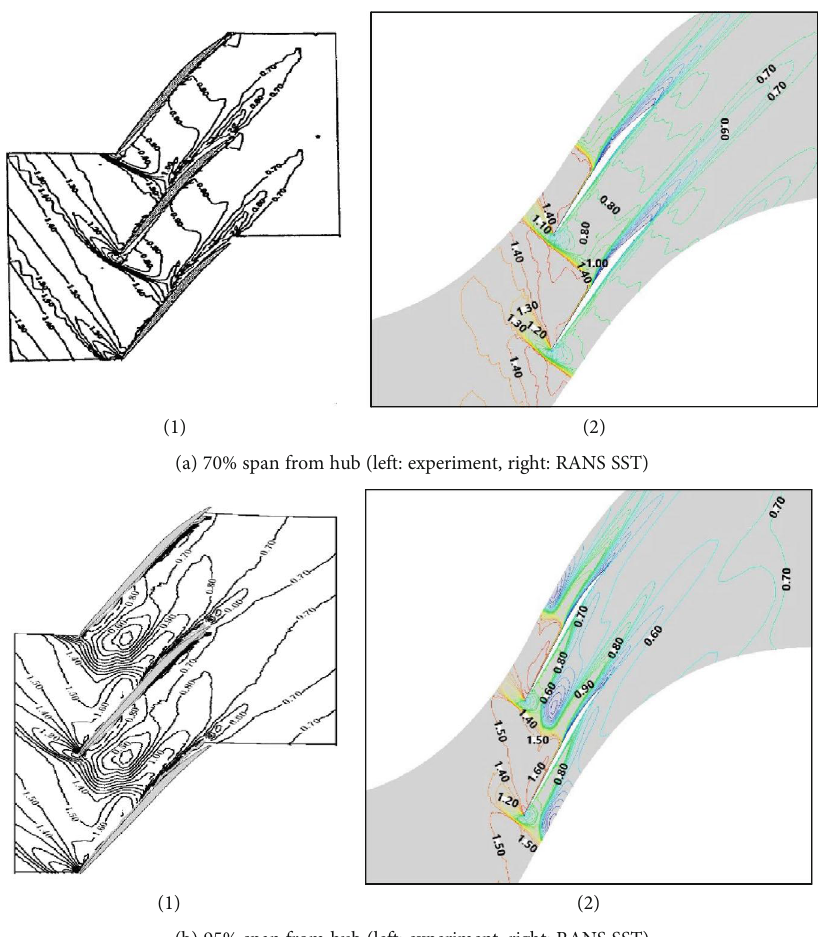
Figure 14: Comparisons of predicted and measured relative Mach number at two typical blade spans for near stall